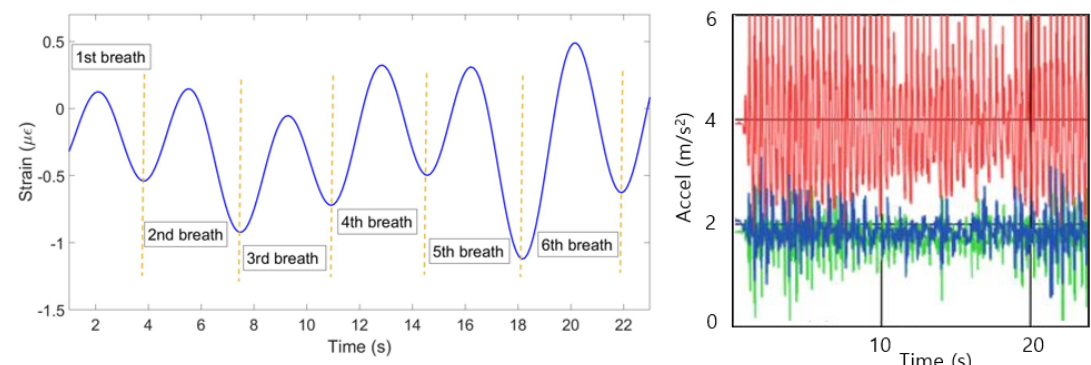
Figure 25. Breathing pattern for the second volunteer in the running position reconstructed based on the 10 FBGs strain patterns ( left ) and obtained from the reference sensor ( right